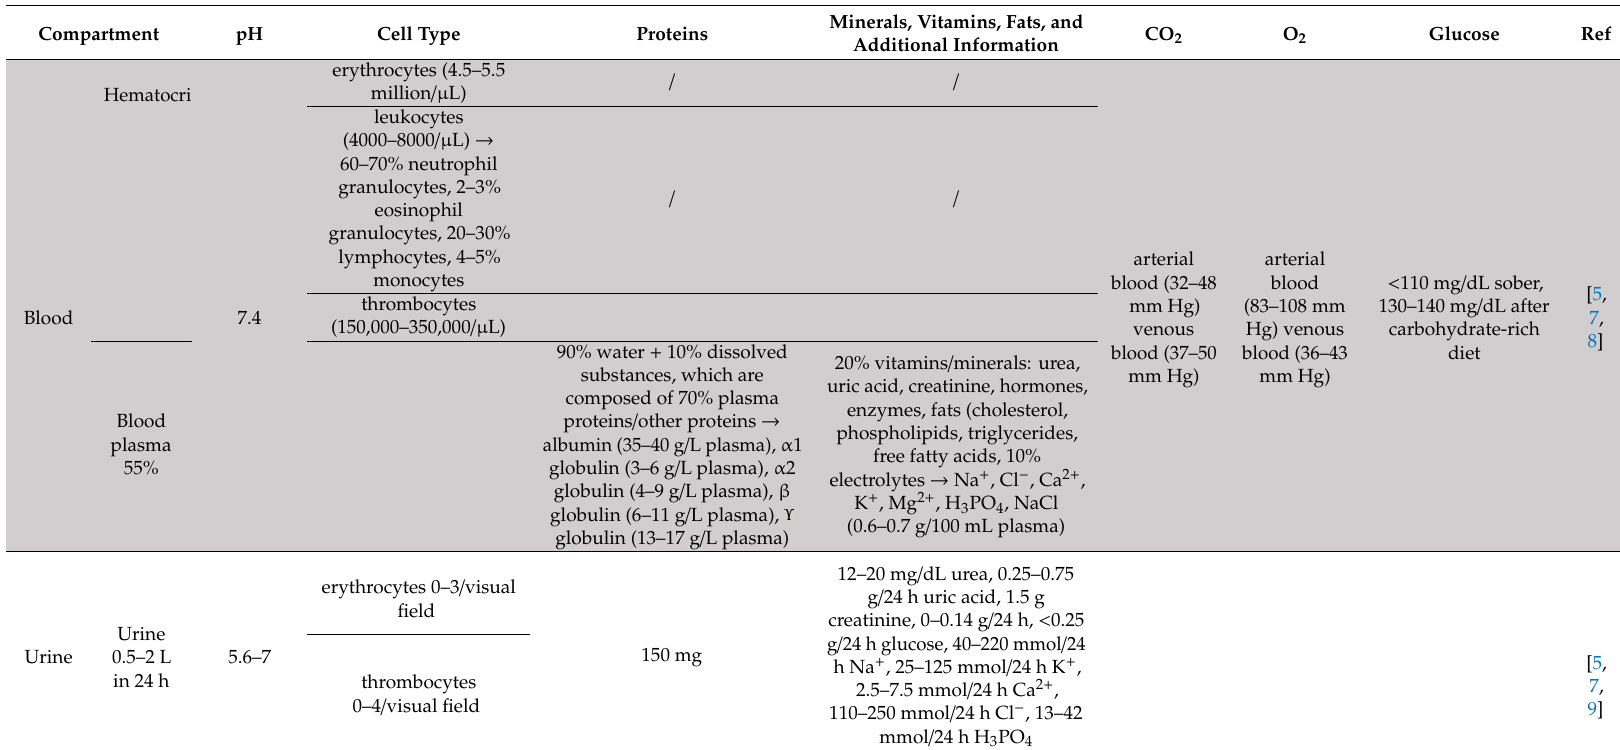
Table 1. Compartments of the human body and their physiologic compositions.